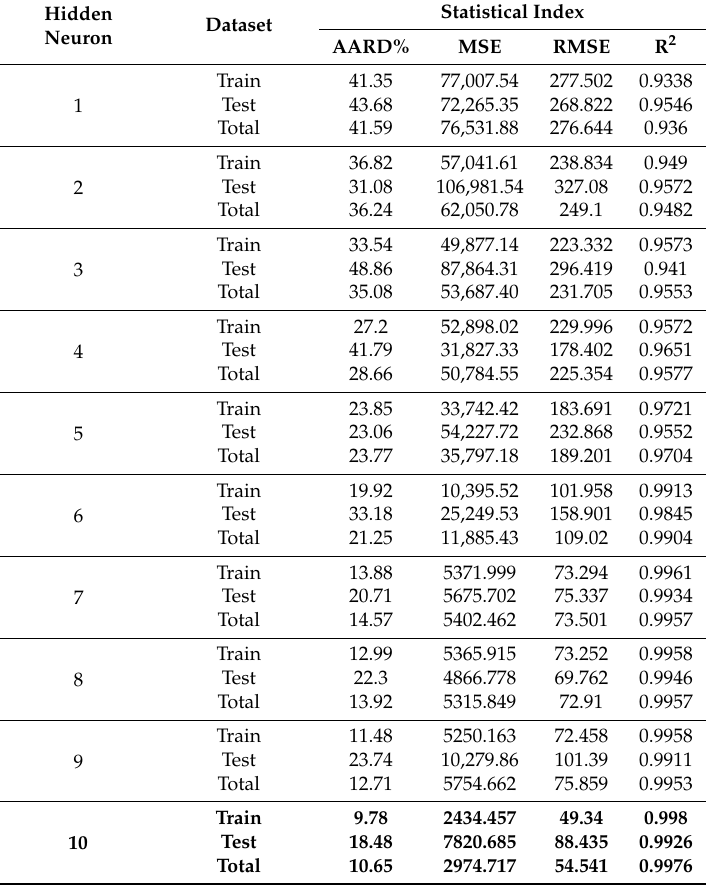
Table 5. Performance of cascade feedforward (CF) model with di ff erent hidden